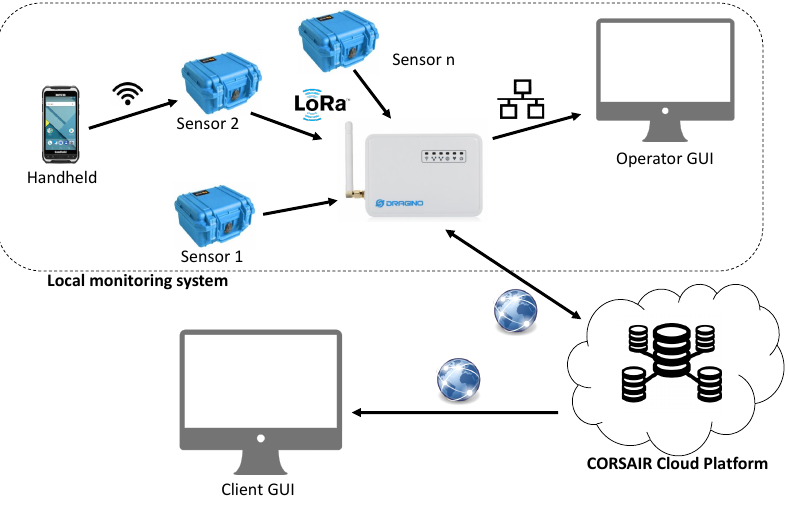
Figure 1. CORSAIR equipment